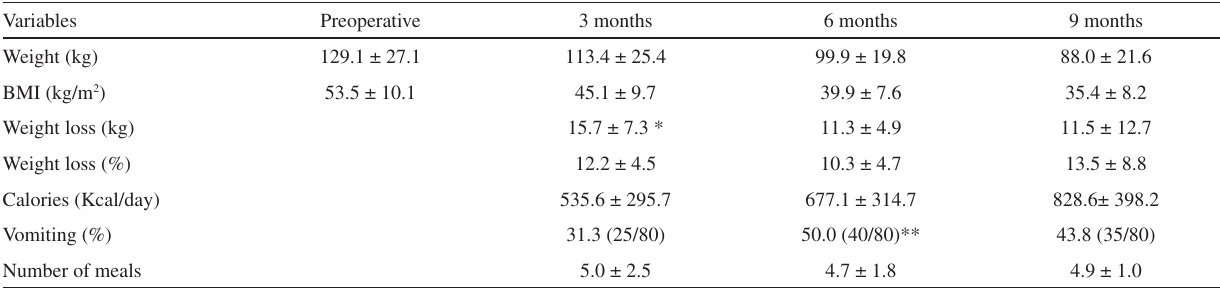
Table 1 - General population profile